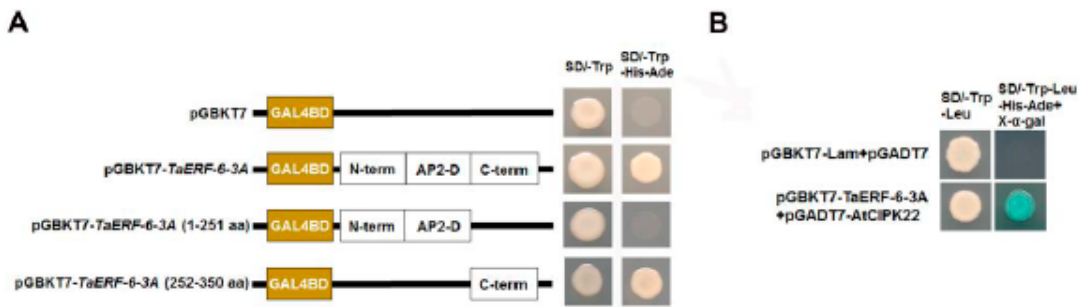
Figure 13. Transcriptional activity and yeast two-hybrid analysis of TaERF-6-3A. ( A ) Transcription activity analysis of TaERF-6-3A. The yeast cells were plated on SD/-Trp and SD/-Trp/-Ade/-His media. AP2-D, AP2/ERF domain; ( B ) Analysis of the interaction between TAERF-6-3A and AtCIPK22 in yeast.